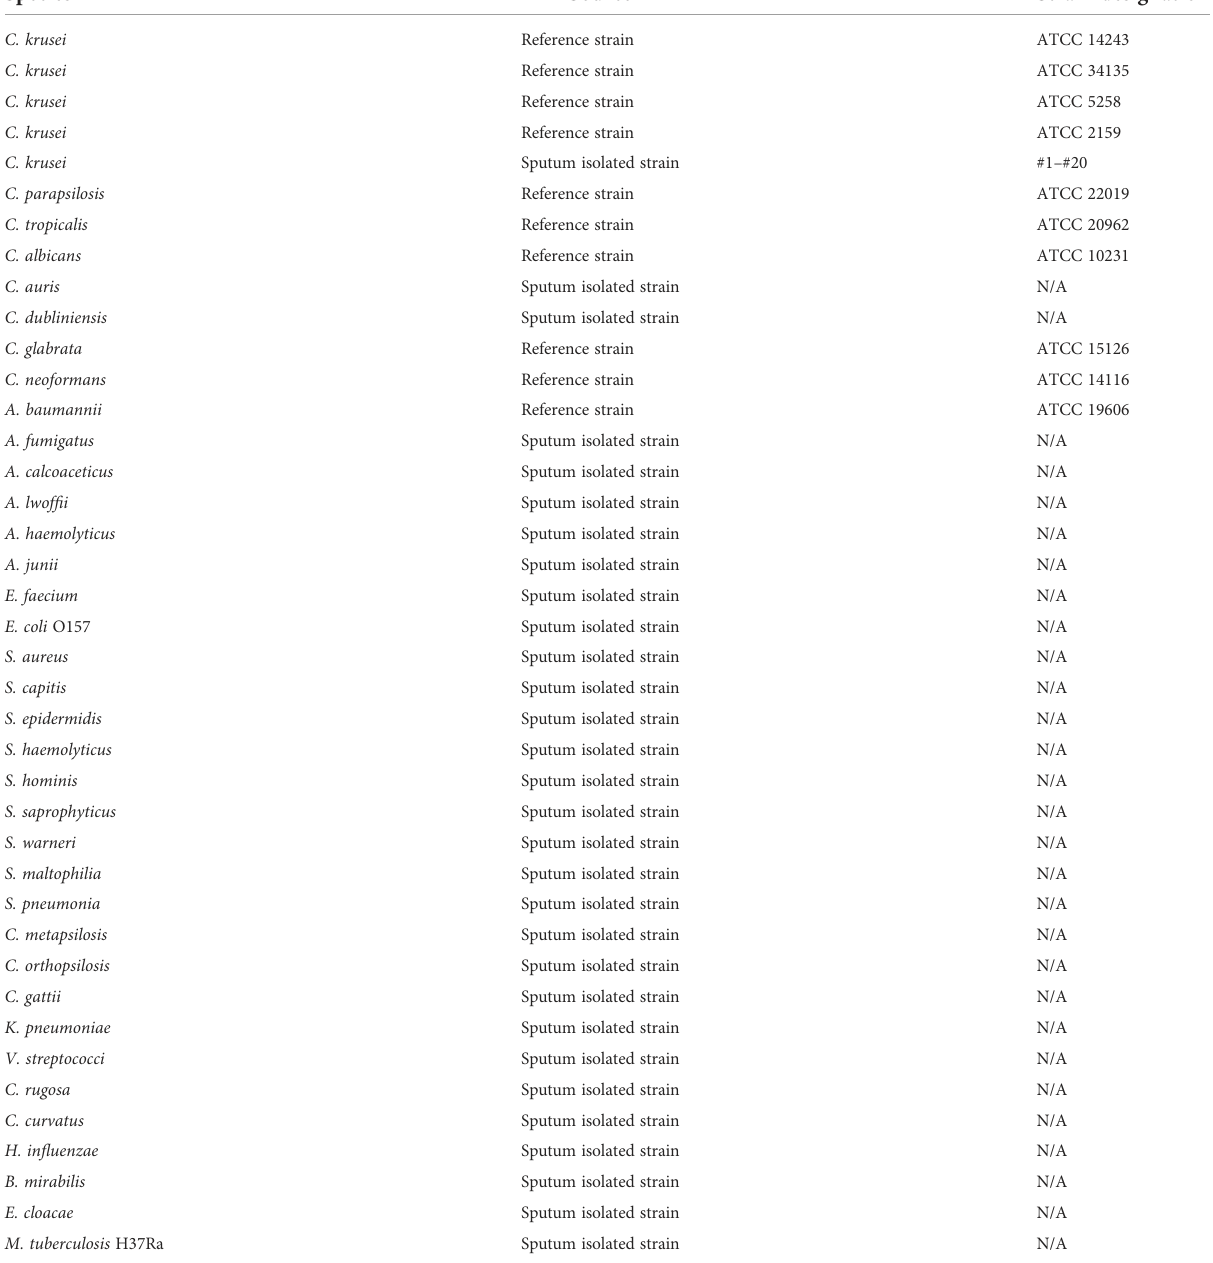
TABLE 2 Yeast and bacterial strains used in this study.